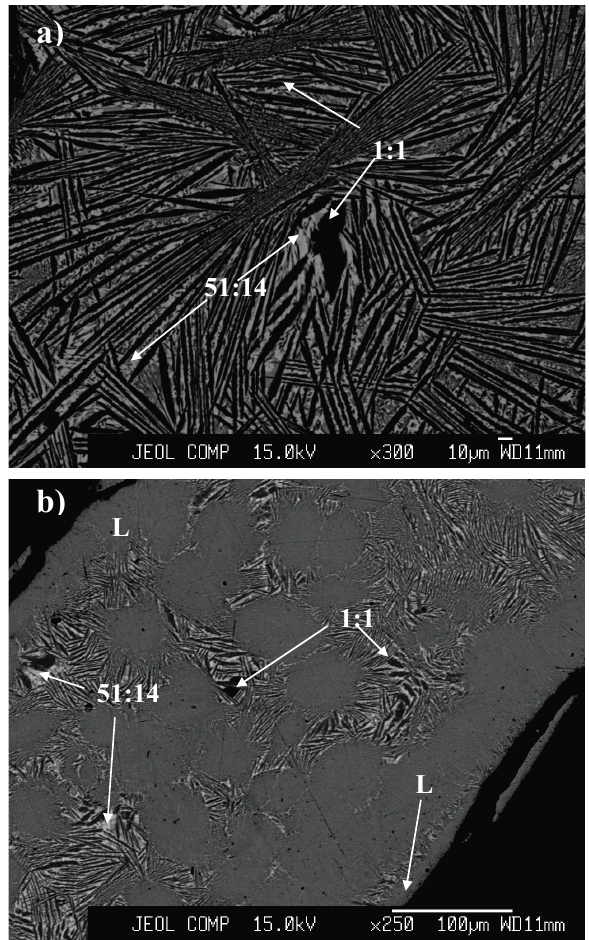
Figure 5. Microstructure of Cu-Zr-Ti alloy quenched on a cold plate (a) and using piston quenching (b). Legend: L- amorphous phase, 1 W 1 -CuTi phase and 51 W 14 -Cu 51 Zr 14 phase.